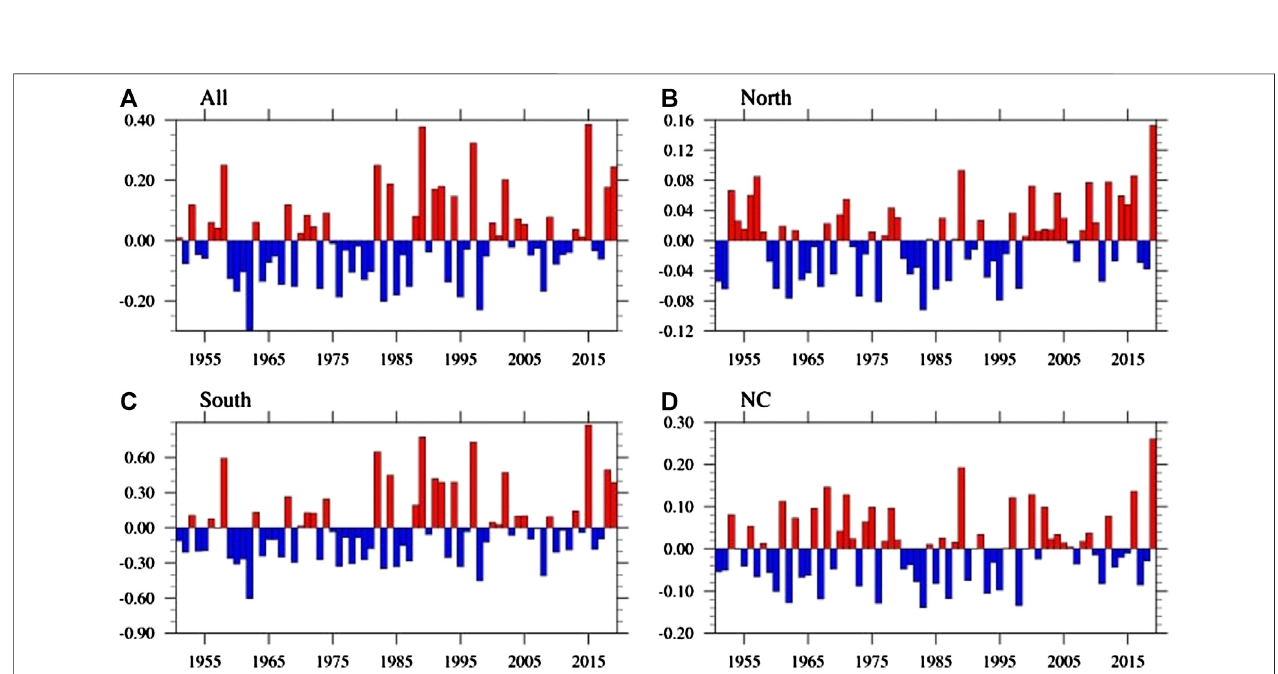
Figure 4B ; − 0.052 mm/day, Figure 4C ). The above analysis